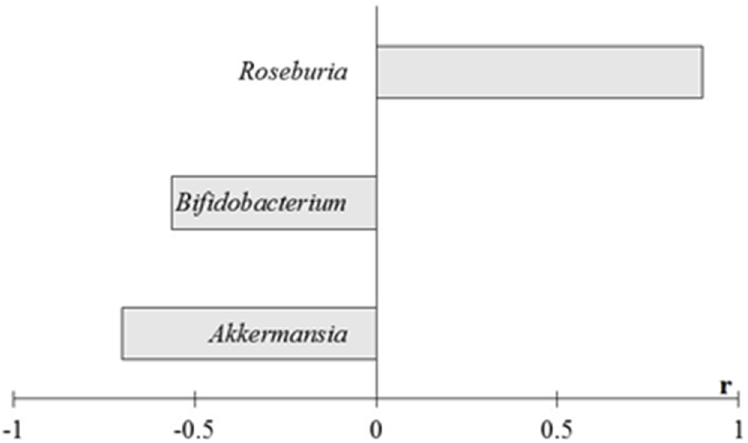
Figure 11. Coefficients of correlation between relative abundances of bacterial taxa in intestinal microbiome and BGL at the end of the experiment. Notes: total data for all animals, the results of the study are presented, using p < 0.05. A search for correlations between the studied parameters was performed using Spearman’s test.